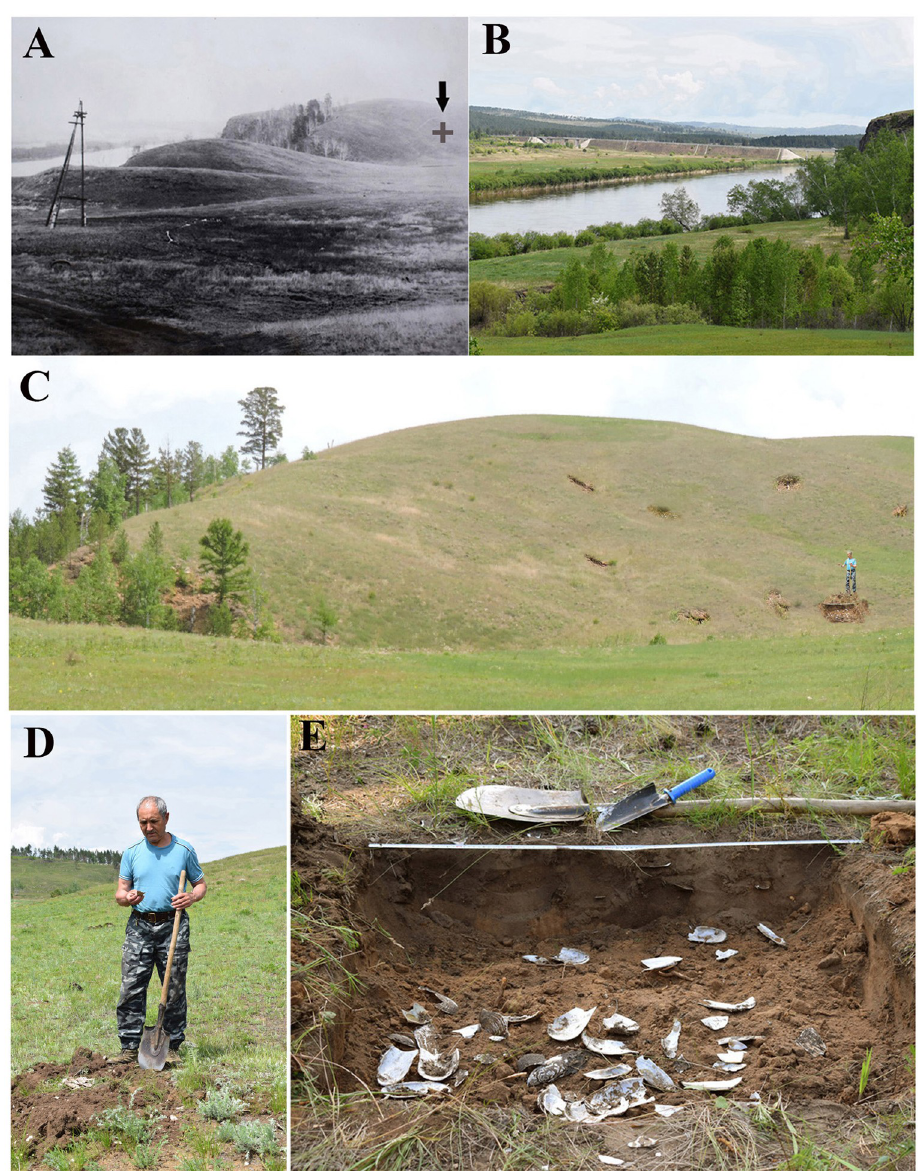
Fig 2. Excavations deposits on territory of the ancient site on a bank of the Ingoda River downstream of the Darasun settlement. A –location of this site identified in 1975 (marked by arrow + ), B –appearance that location in 2019; C, D–trial excavation at the site in 2019; E–excavation deposits 3 with the layer of pearl mussel shells.